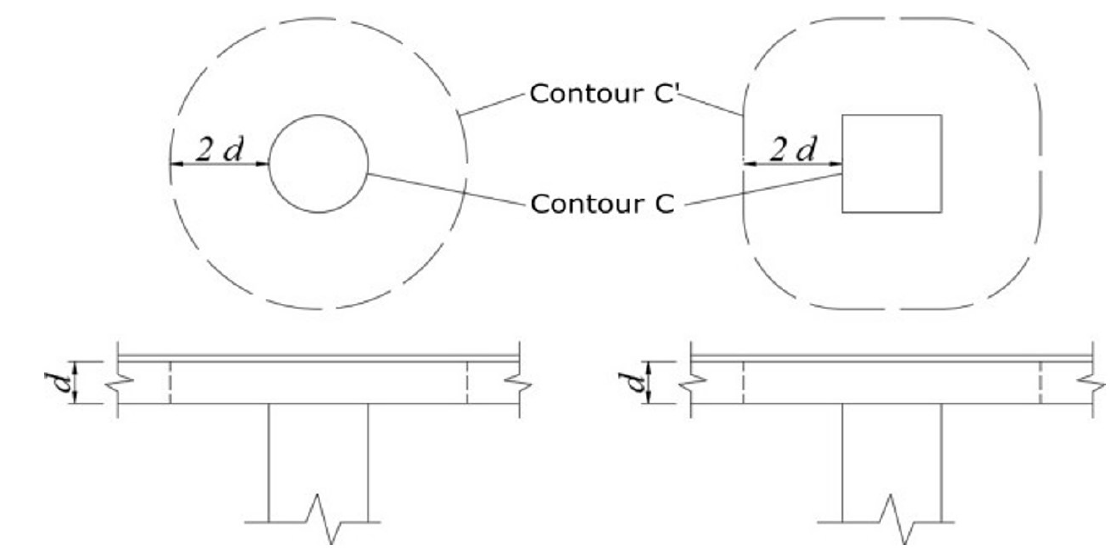
Figure 1. Critical Shear Perimeter C and C '(Adapted from ABNT NBR 6118 (2014)